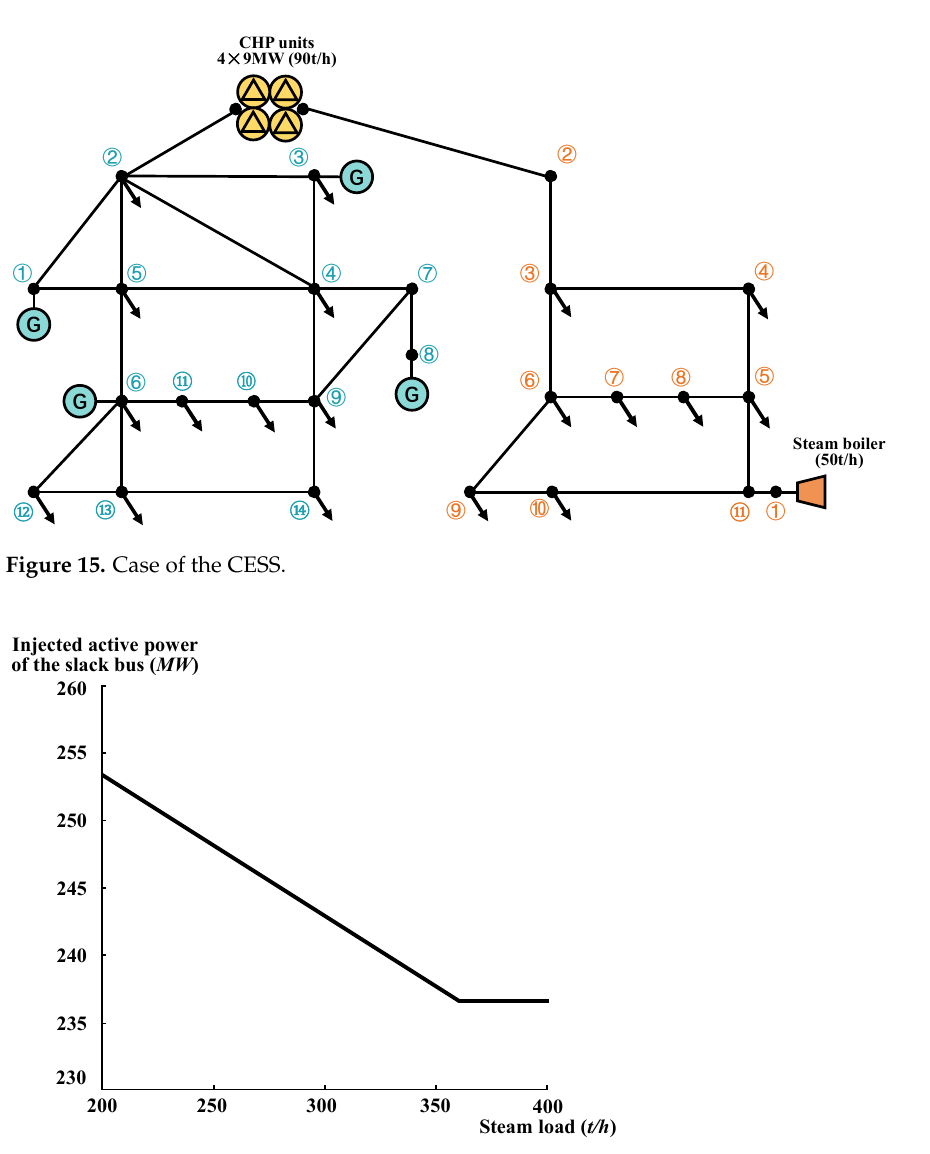
Figure 16. Relationship between the injected active power of the slack bus and the steam heating load.